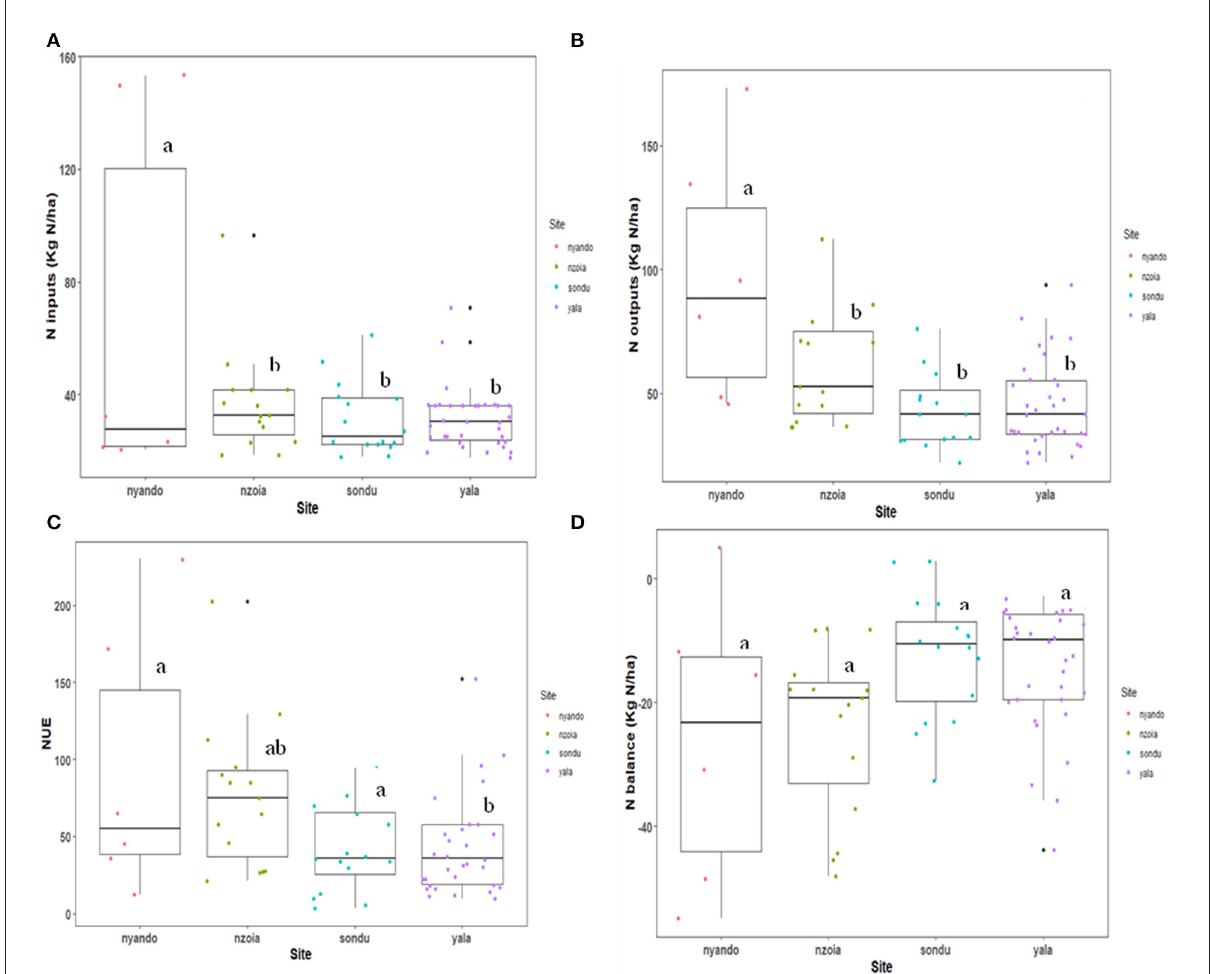
(Figures 2, 3). NUEs exceeding 100% in Nyando and Sondu for maize farmers (Figure 1C) not applying mineral N represented excessive N mining in the